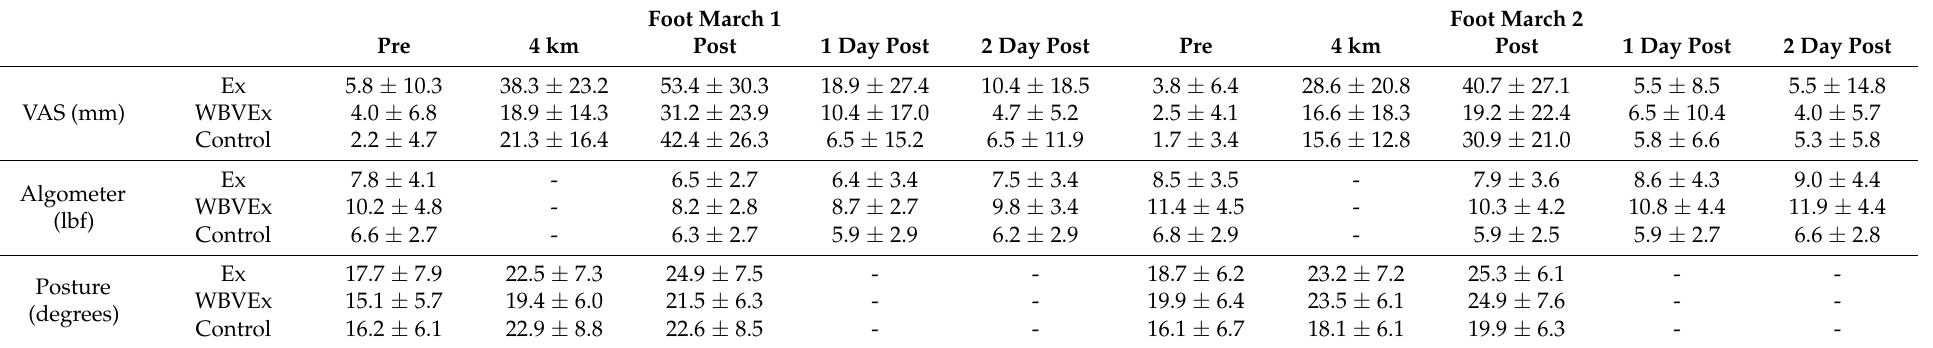
Table 2 Legend: All data are presented as means ± standard deviation. Abbreviations: millimeters (mm), pound-force (lbf), kilometer (km), whole body vibration and core exercise group (WBVEx), exercise group